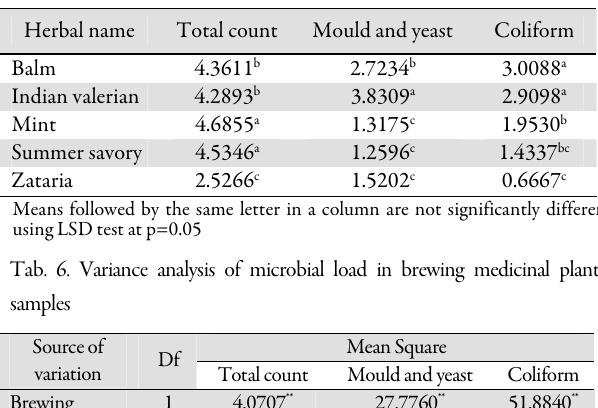
Tab. 5. Mean squares of microbial load of the studied medicinal plants